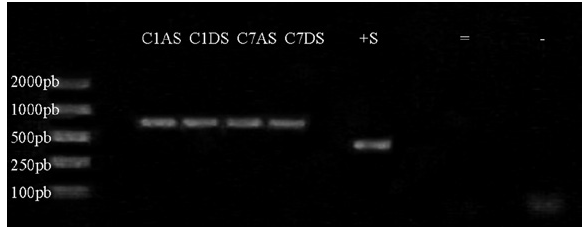
Fig. 4. – Nested PCR amplification products using an EasyLadder I - Bioline (L) for C. cf. subsalsa Adriatic genotype (where C1AS, C1DS are the UNISS7 strain and C7AS, C7DS are the UNISS11 strain), C. subsalsa CCMP217 culture (+S), and two negative con- trols (=, –).